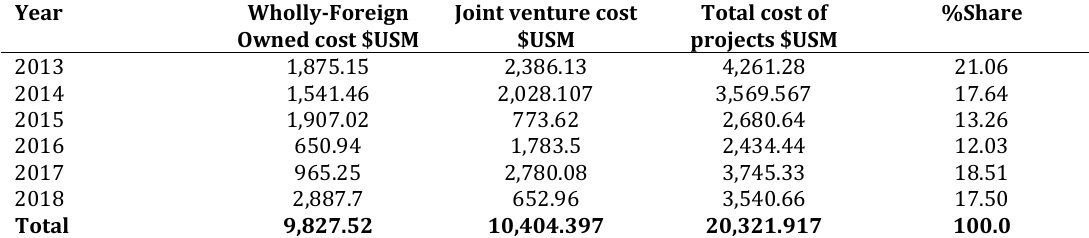
Table 3: Breakdown of total cost of FDI projects in Ghana from 2014 to 2018